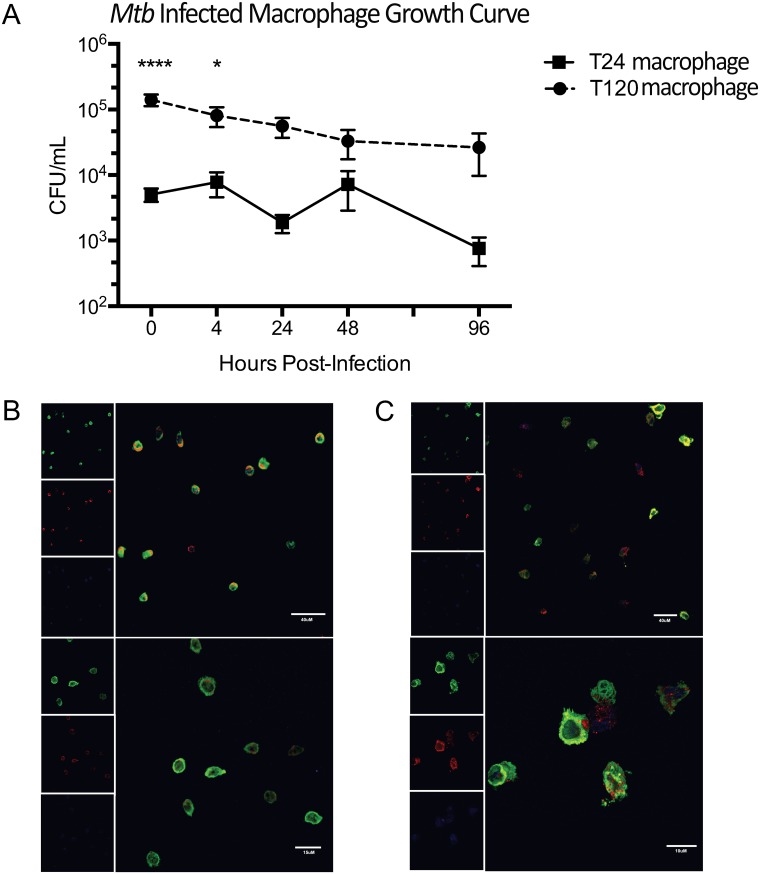
Comparison of Mtb-infected T24 monocytes vs. T120 differentiated macrophages.(A) Log10-bacterial burden at 0, 4, 24, 48 72, and 96h post-infection. T24 monocytes are indicated by red squares and blue circles indicate T120 differentiated macrophages infected with Mtb. Cellular morphology and bacterial uptake at time-point 0 in Mtb-infected phagocytes that were allowed to differentiate for (B) 24h and (C) 120h before infection. Cells were stained for MAC387 (green), Mtb (red), and To-PRO-3 (blue). Upper panels show medium magnification (40x), and lower panels indicate high magnification (63x). Data are means ± SEM from 4 or 6 independent experiments. In Prism v6.0, a Two-Way ANOVA with Sidak’s multiple comparisons test was performed where ****, P<0.0001; *, P<0.05.